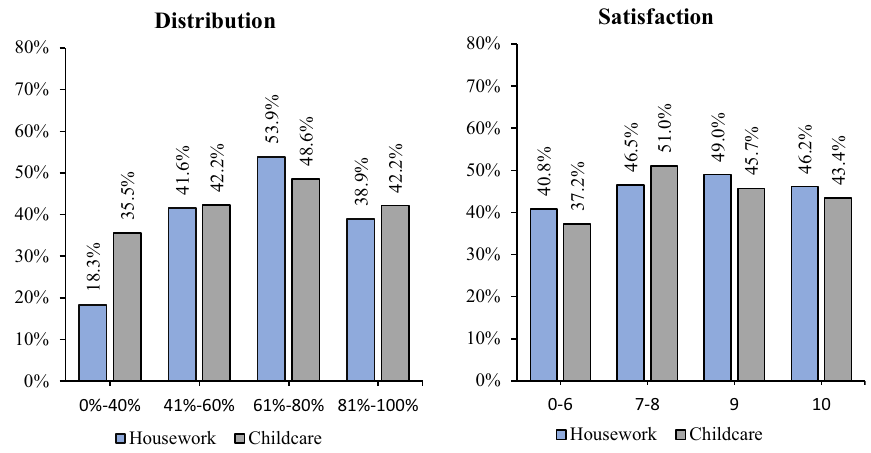
Fig. 2 Percentage of women intending to have another child, by housework and childcare distribution and satisfaction. Percentages are